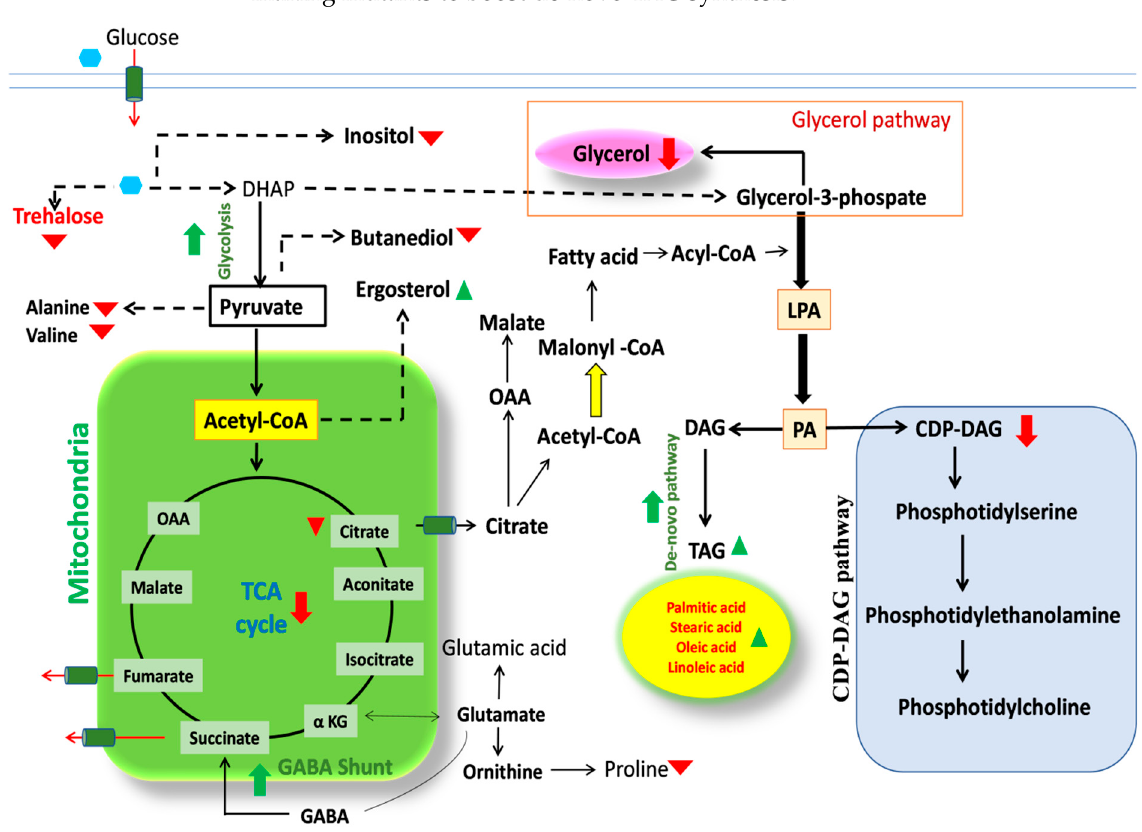
Figure 9. Metabolic pathway of R. toruloides representing diversion of CDP-DAG pathway for phospholipids synthesis and glycerol pathway into de novo TAG synthesis pathway under nitrogen limitation (red key denotes down regulation and green key denotes up-regulation).